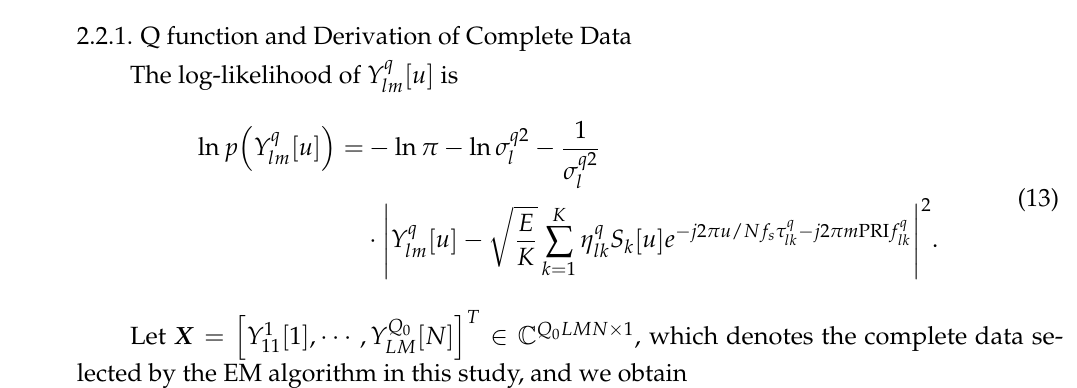
Figure 3. The generalized adaptive expectation maximization (GAEM) algorithm, which is accelerated by squared iterative methods (SQUAREM)